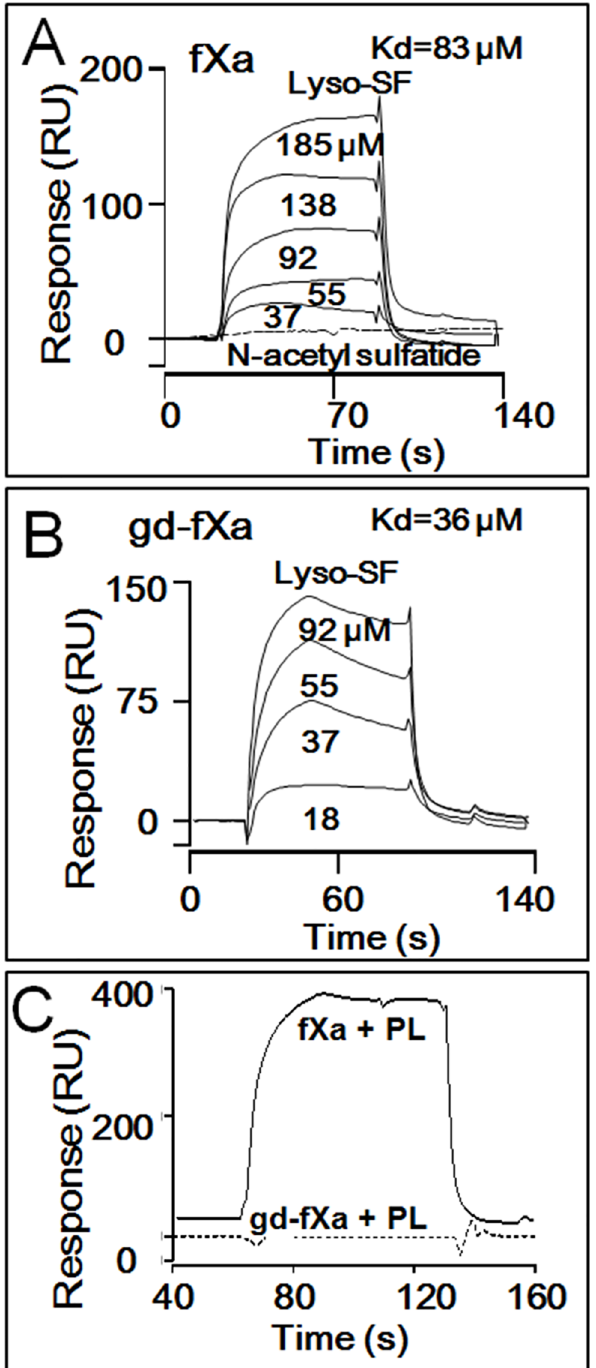
Fig 4. Binding of Lyso-SF to fXa and Gd-fXa using SPR. Surface Plasmon Resonance (SPR) was used to monitor binding of lyso-SF to BEGR-fXa i and BEGR-gd-fXa i . (A) Sensorgram depicting the dose-dependent binding of lyso-SF (from top to bottom; 185, 138, 92, 55, 37 μ M) to BEGR-fXa i . Lyso-SF (62.5 μ M) did not exhibit any binding to N-acetylsulfatide (dotted line). (B) Sensorgram depicting the dose-dependent binding of lyso-SF (from top to bottom; 92, 55, 37, 18 μ M) to BEGR-gd-fXa i . (C) PC/PS vesicles exhibited binding to BEGR-fXa i but not to BEGR-gd-fXa i